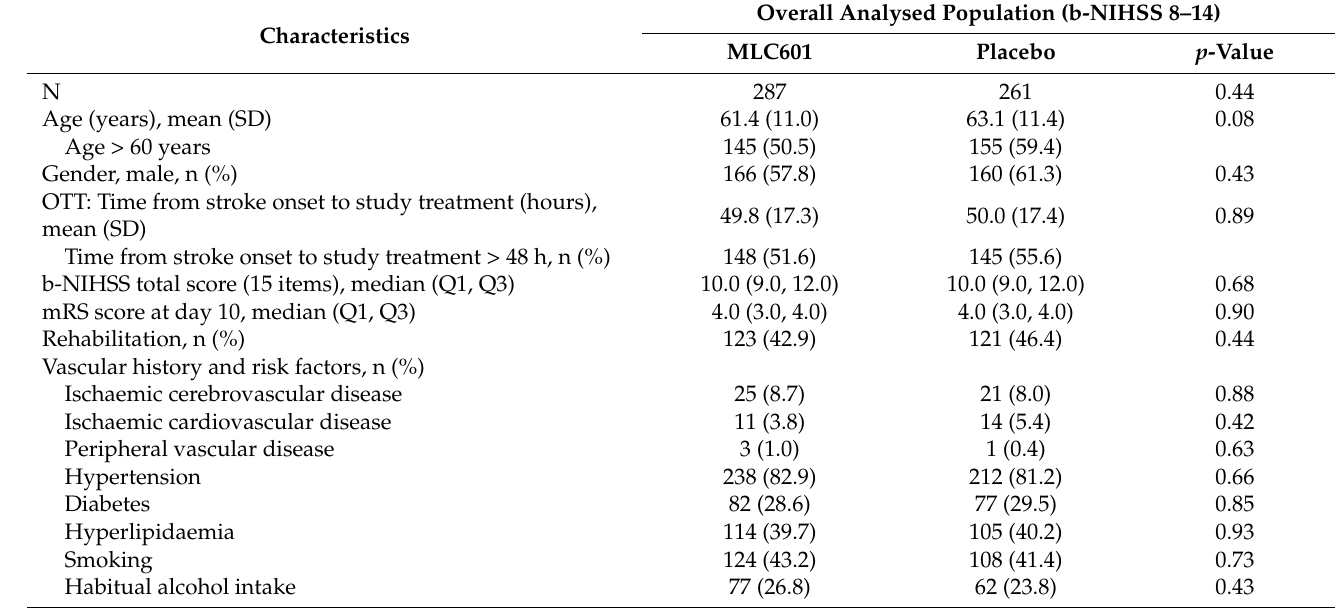
Table 1. Baseline characteristics in overall analysis